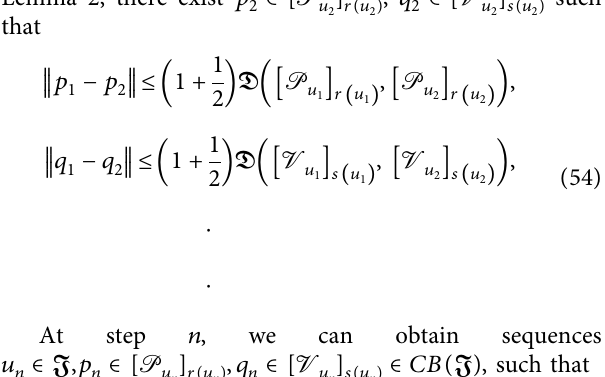
Algorithm 1. At n � 0, start with initial value u